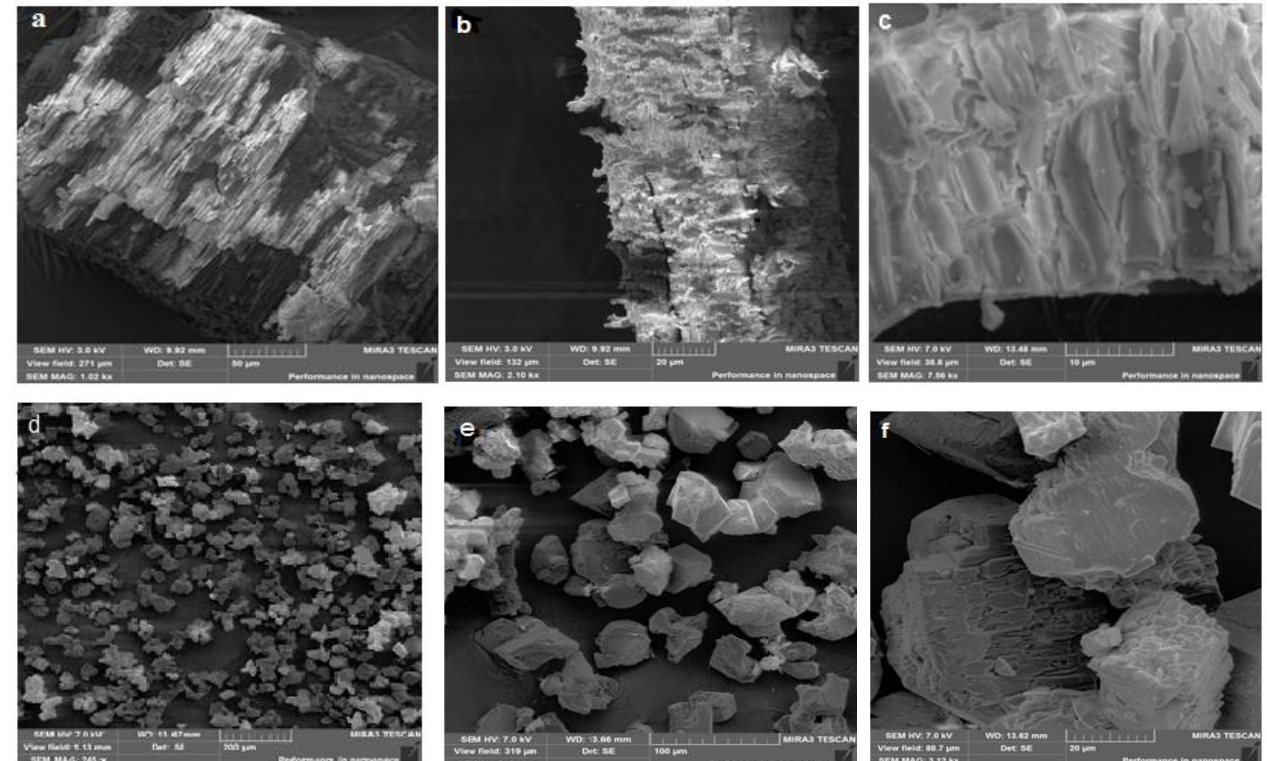
Figure 14. Scanning electron micrographs of β -CD ( a – c ) and the β -CD – resveratrol (2:1) inclusion